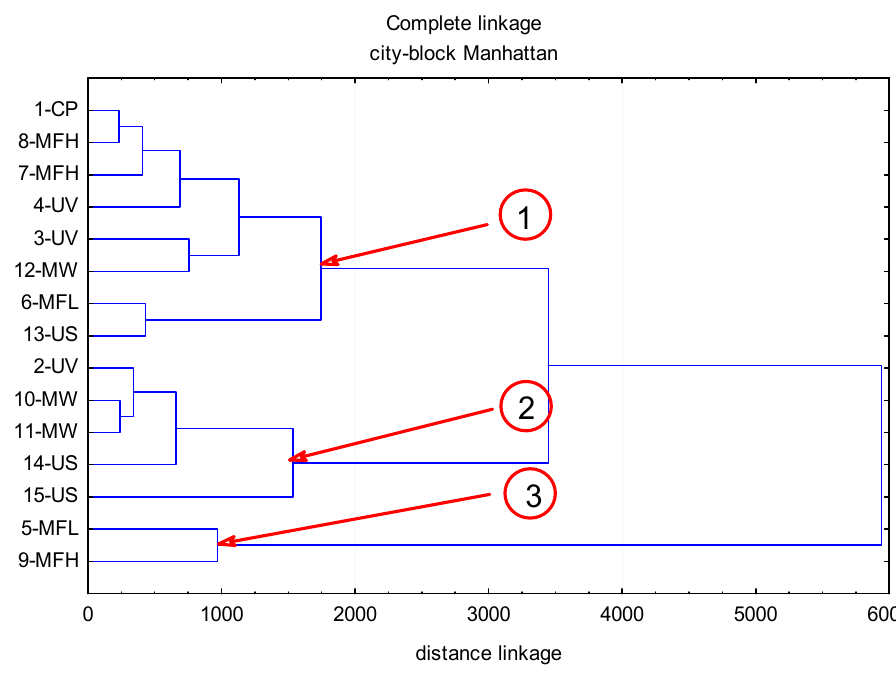
Figure 1. The influence of abiotic stress factors (UV-C electromagnetic field of the microwave field, ultrasound) on the content of anthocyanins in chokeberry fruits.